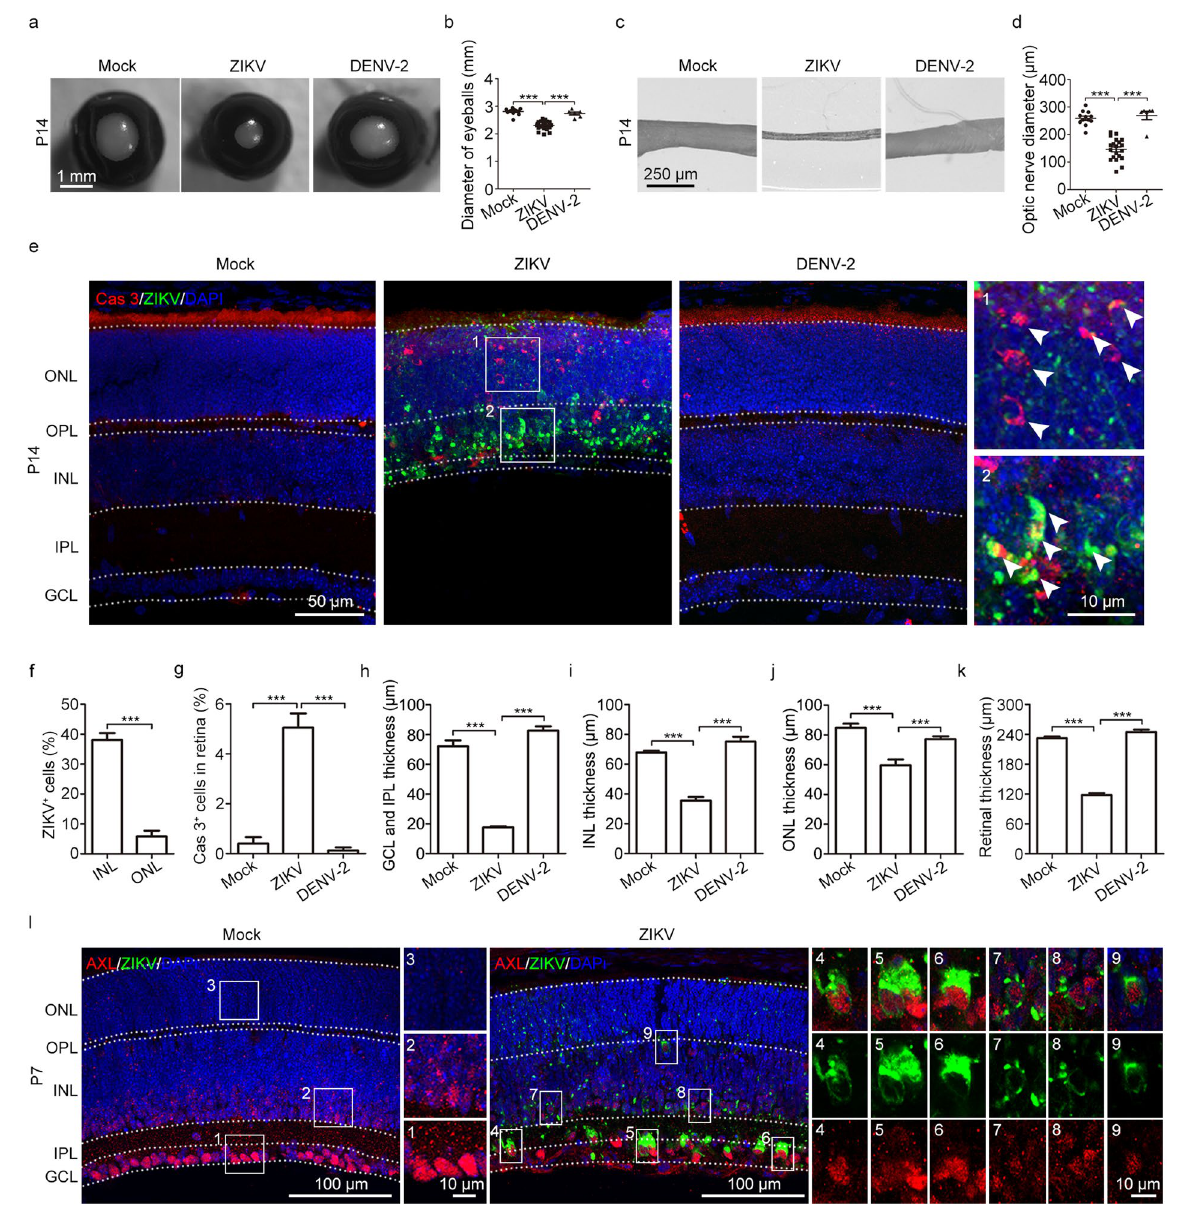
Figure 2. Visual defects caused by maternal ZIKV infection. (a) Representative images of P14 eyeballs. (b) Diameters of P14 eyeballs. (c) Representative images of P14 optic nerves. (d) Diameters of P14 optic nerves. (e) Representative images of the retina stained for Cas3 and ZIKV. White arrows, ZIKV-positive or Cas3- positive cells. (f) Percentage of ZIKV-infected cells within the INL and ONL. n = 10 samples from three independent experiments. (g) Percentage of Cas3-positive cells within the retina. n Mock = 5, n ZIKV = 9, n DENV-2 = 5 samples from three independent experiments. (h – j) Retinal GCL and IPL thickness (h), INL thickness (i), and ONL thickness (j), respectively. n Mock = 14, n ZIKV = 13, n DENV-2 = 11 samples from three independent experiments. (k) Quantification of retinal thickness. n Mock = 14, n ZIKV = 19, n DENV-2 = 11 samples from three independent experiments. (l) AXL and ZIKV expression in the P7 retina. Quantification data are presented as the mean ± SEM. Student’s t -test (f) or one-way ANOVA with Bonferroni’s post hoc test, *** p <